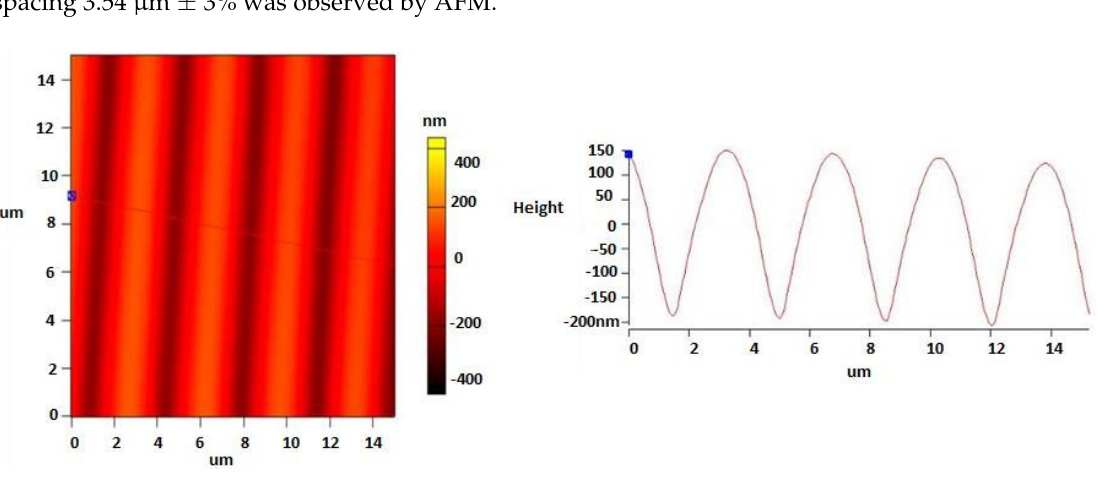
Figure 5. Two-dimensional AFM scans of the SRG after thermal treatment. Table 3. Diffraction efficiency (DE %) and surface modulation of SRG at different stages of the experiment.